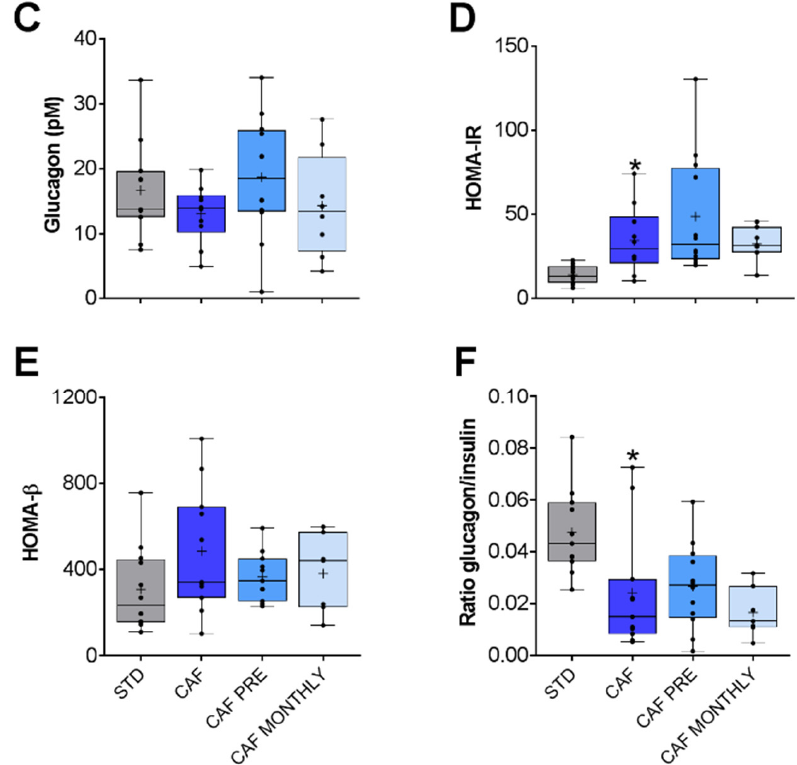
Figure 3. Glucose metabolism-related biochemical parameters: ( A ) Glucose. ( B ) Insulin. ( C ) Glucagon. ( D ) HOMA-IR. ( E ) HOMA- β . ( F ) Glucagon/insulin ratio. STD: lean rats fed a standard diet; CAF: rats fed a cafeteria diet; CAF PRE: rats receiving preventive treatment of GSPE during 10 days before cafeteria diet intervention; CAF MONTHLY: rats receiving GSPE treatment during 5 days once per month simultaneously fed with cafeteria diet. Values are represented as boxplots showing the median and the IQR. Means are represented as +. * p -value < 0.05 compared to STD rats.